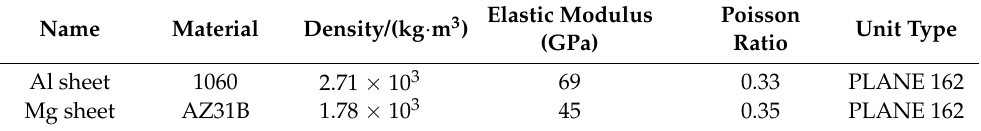
Table 3. Material parameters of structural field model.